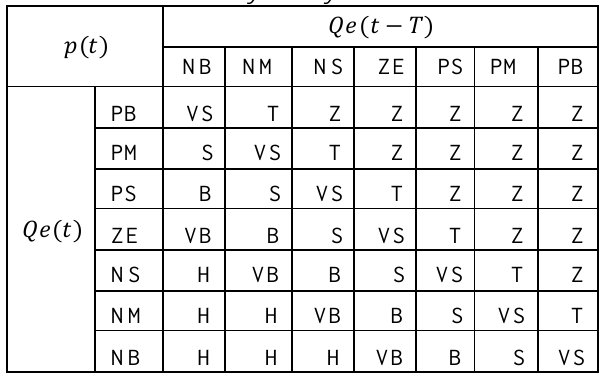
Table 3. Fuzzy rule system of FLRED